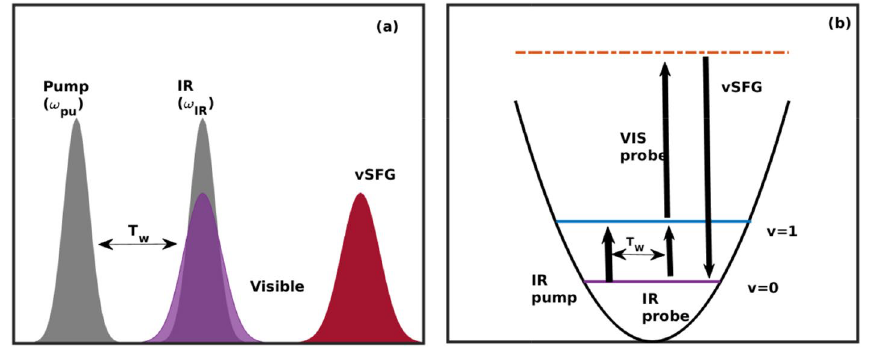
Figure 1. ( a ) Schematic representation of the pulse sequence for time-dependent 2D-vSFG, ( b ) energy level diagram for time-dependent 2D-vSFG